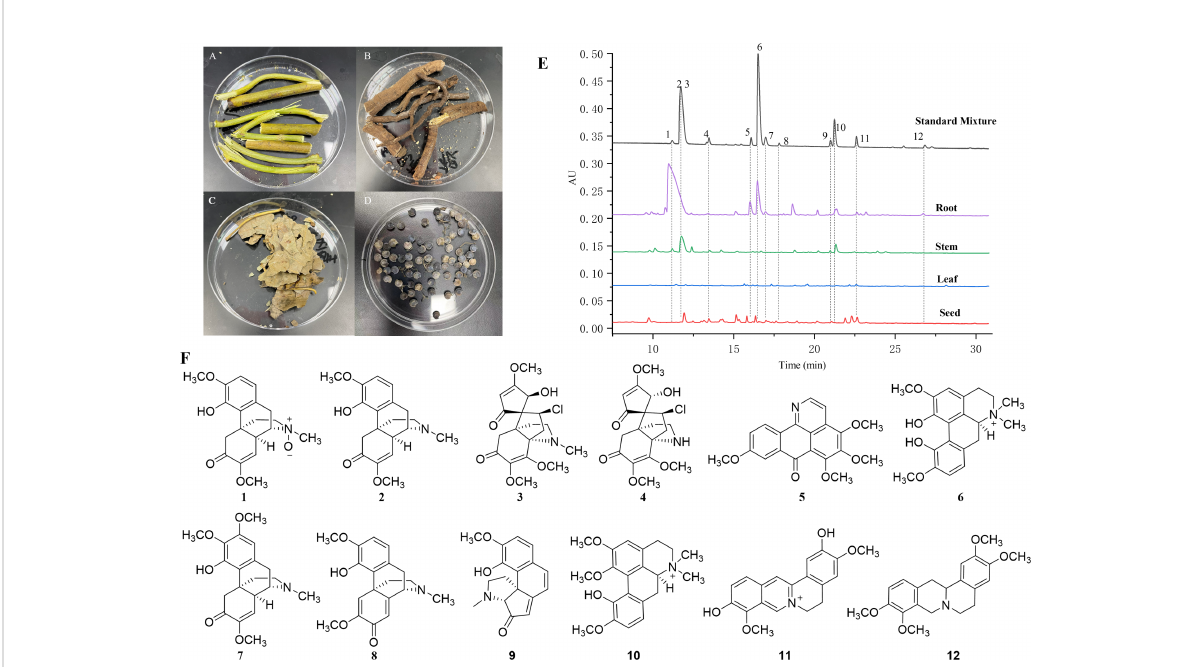
FIGURE 1 Photos and HPLC pro fi les of fresh tissues of S. acutum . (A – D) : the photos of fresh root (A) , stem (B) , leaf (C) , and seed (D) . (E) : HPLC pro fi les of the four tissues and the mixed standards of 12 BIAs from S. acutum . (F) : Chemical structures of 12 selected BIAs, including sinomenine N -oxide (1), sinomenine (2), acutumine (3), dauricumidine (4), bianfugenine (5), magno fl orine (6), 8-demethoxyrunanine (7), sinoacutine (8), sinoracutine (9), menisperine (10), stepharanine (11), and tetrahydropalmatine